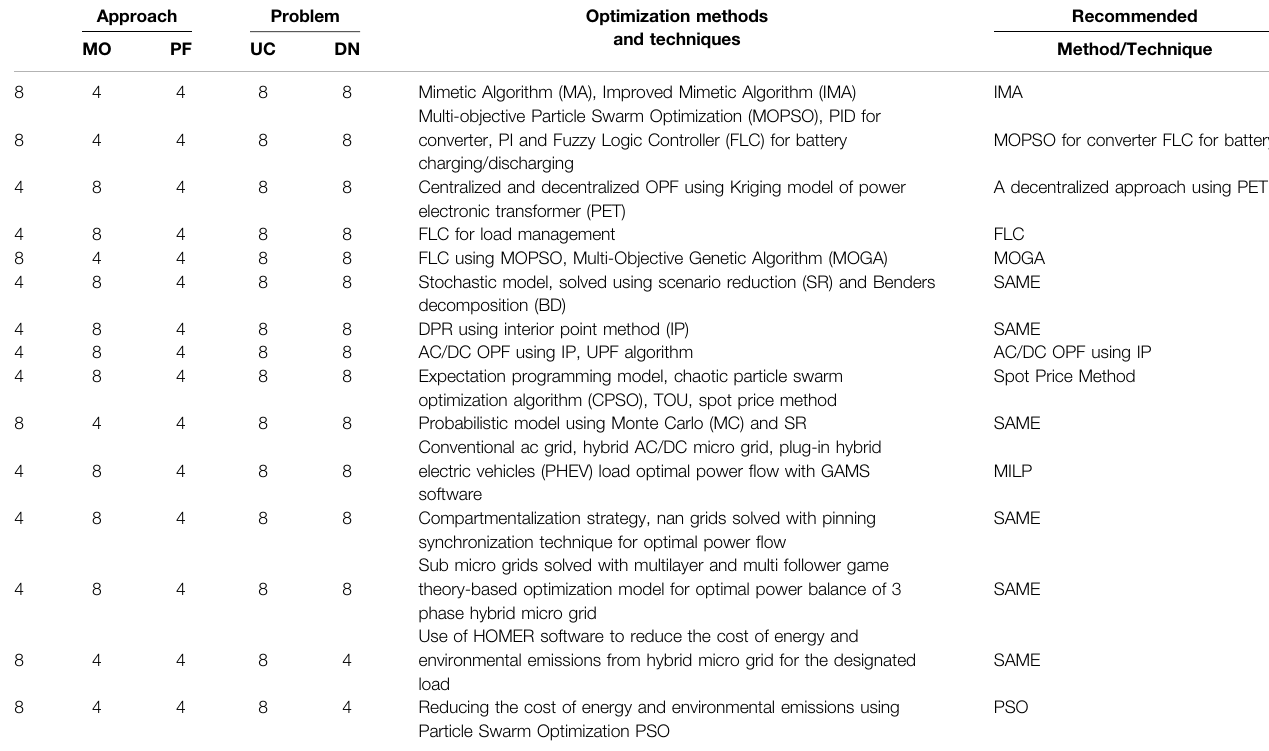
TABLE 4 | Summary of approach optimization technique and methods (Li et al., 2016). Approach